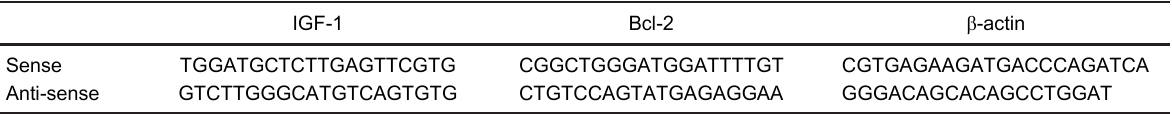
Table 2. Sequence of the primers used in the